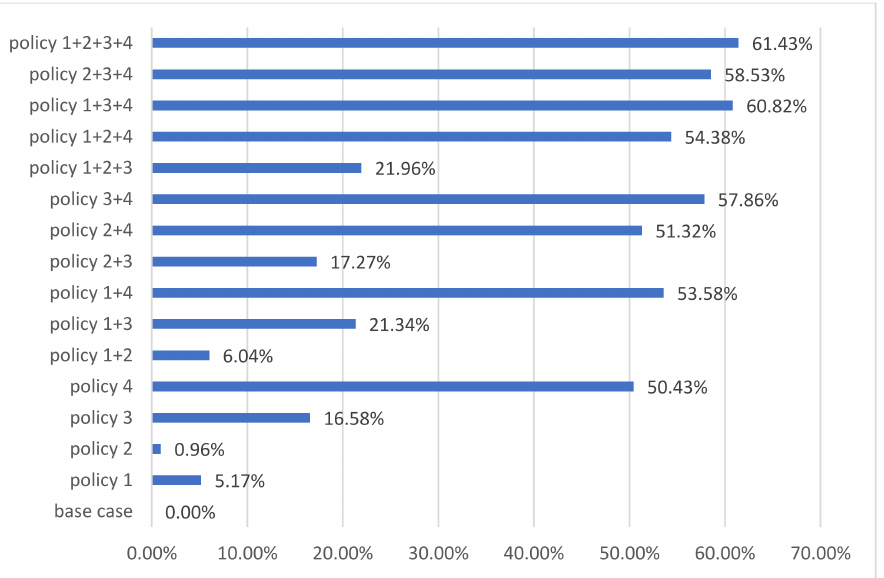
Figure 10. The effect of policy measures on GHG emission stock by policy measures’ implications until